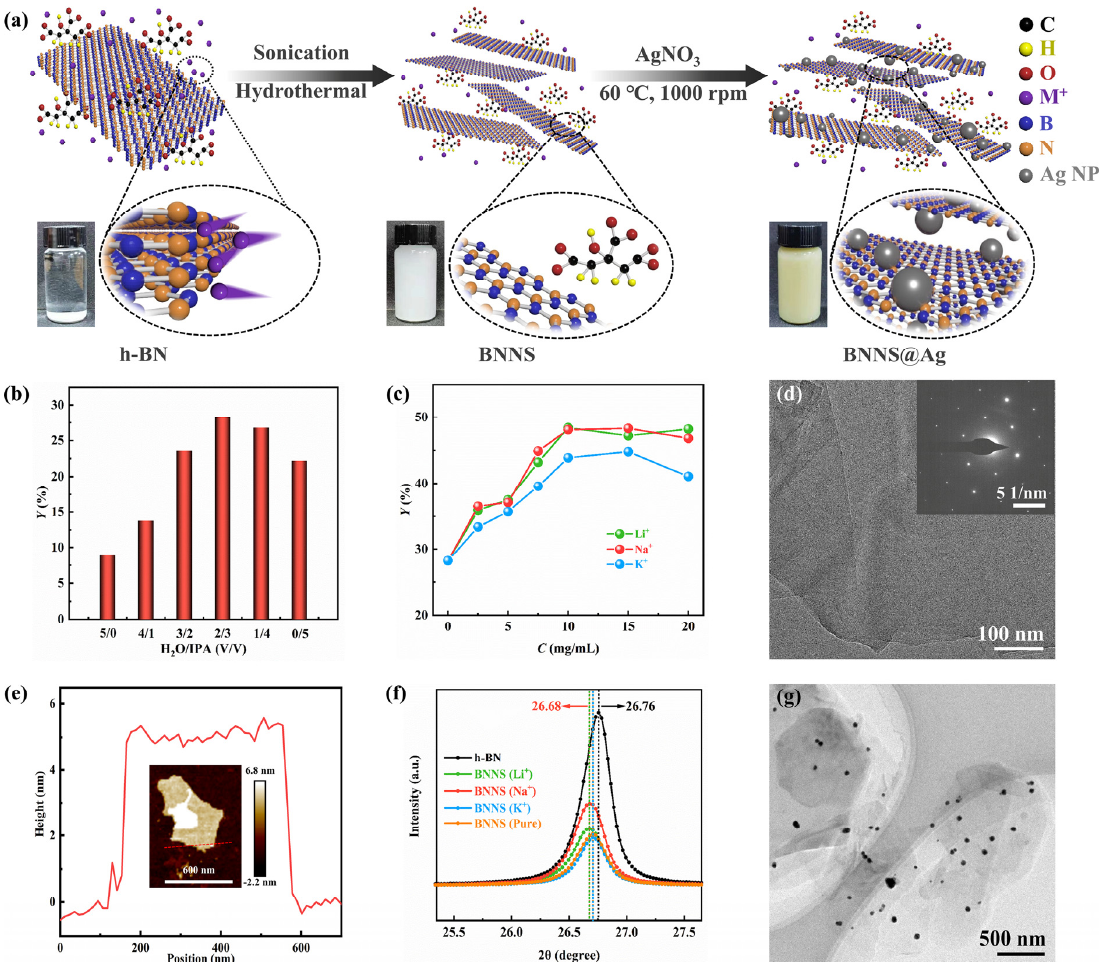
Figure 1. Fabrication of BNNS@Ag. ( a ) Schematic diagram of BNNS fabricated via the liquid-phase exfoliation assisted by alkali metal ions, and in situ synthesis of AgNP on BNNS by citrate. The exfoliated yields of BNNS ( b ) in different ratios of H 2 O and IPA, and ( c ) with different types of alkali metal ions. ( d ) Corresponding electron diffraction pattern of BNNS. ( e ) AFM image of BNNS and corresponding height profiles of BNNS. ( f ) XRD patterns of h-BN, BNNS exfoliated by Li + , Na + , K + , and pure solvent. ( g ) TEM image of BNNS@Ag.